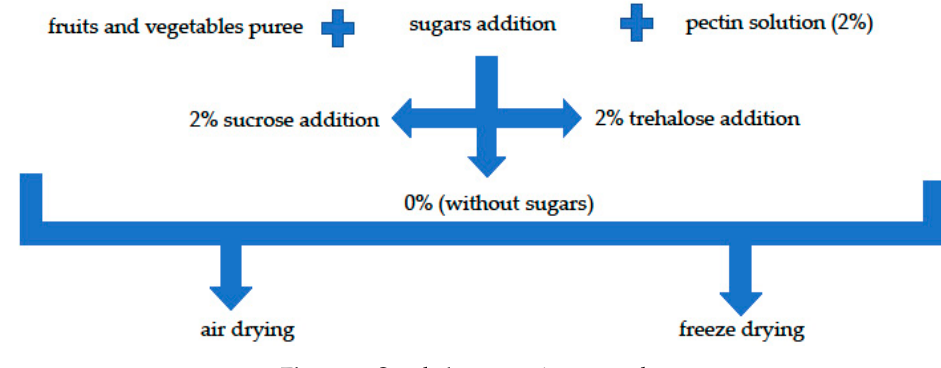
Figure 5. Snacks’ preparation procedure.